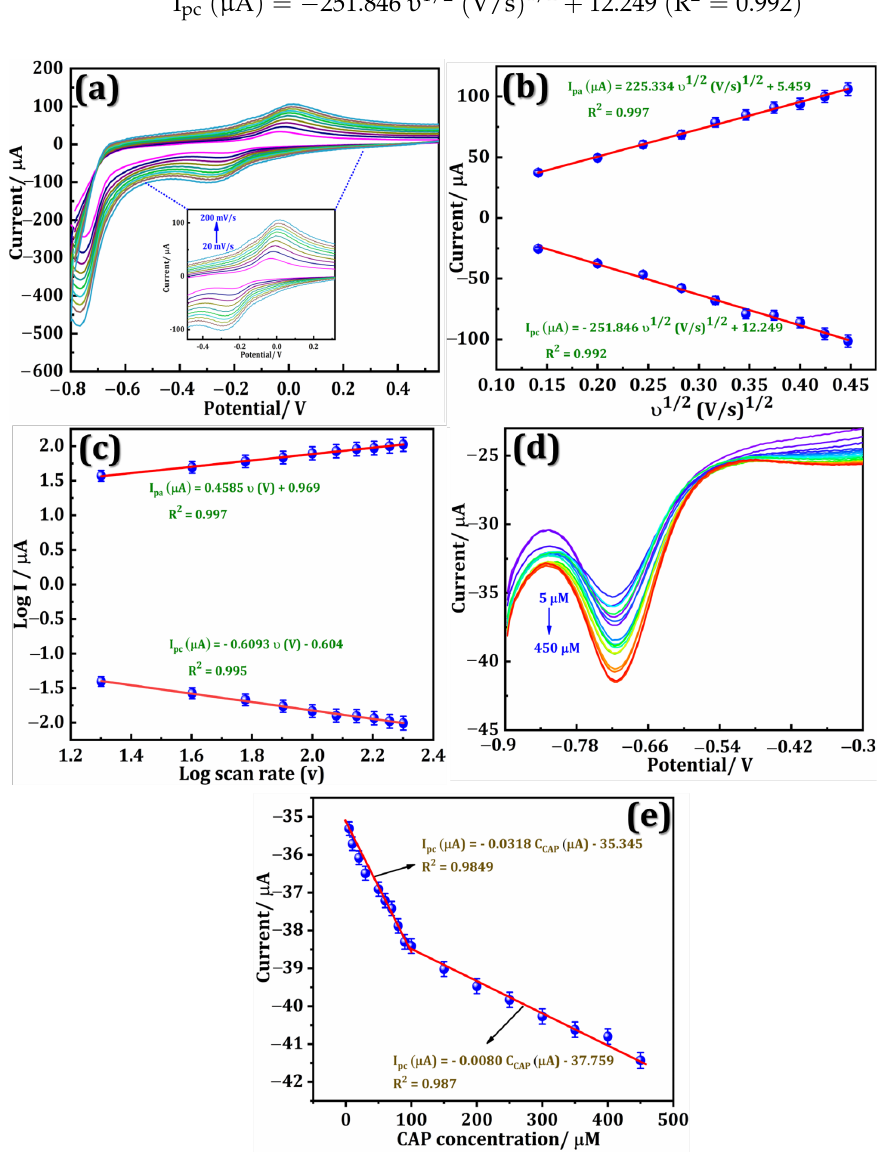
Figure 5. ( a ) CV curves for scan rate ranging from 20 mVs −1 to 200 mVs −1 in the presence of 250 µM CAP (0.1 M PBS, pH 9.0). Linear plots of ( b ) current vs. square root of scan rate and ( c ) log current vs. log square root of the scan rate. ( d ) DPV curves of the Sr@Se/PGCN/GCE were obtained at the CAP concentration ranging from 5 to 450 μM in 0.1 M PBS (pH 9). ( e ) Linear graph of increasing concentration of CAP against I pc .